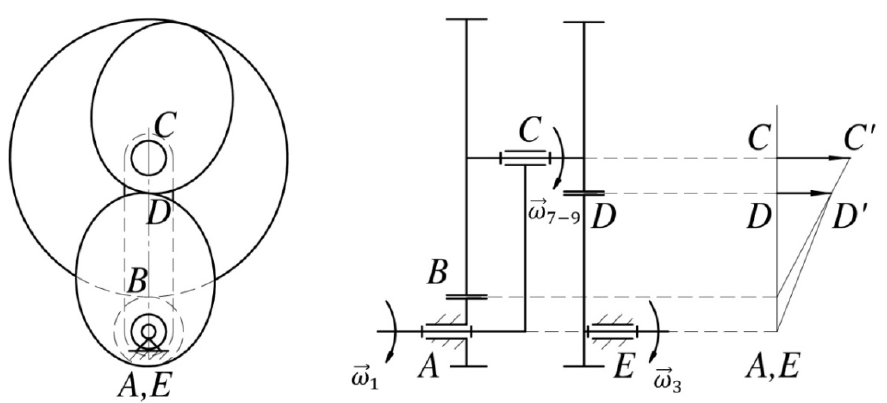
Figure 3. Plan of the mechanism velocities.